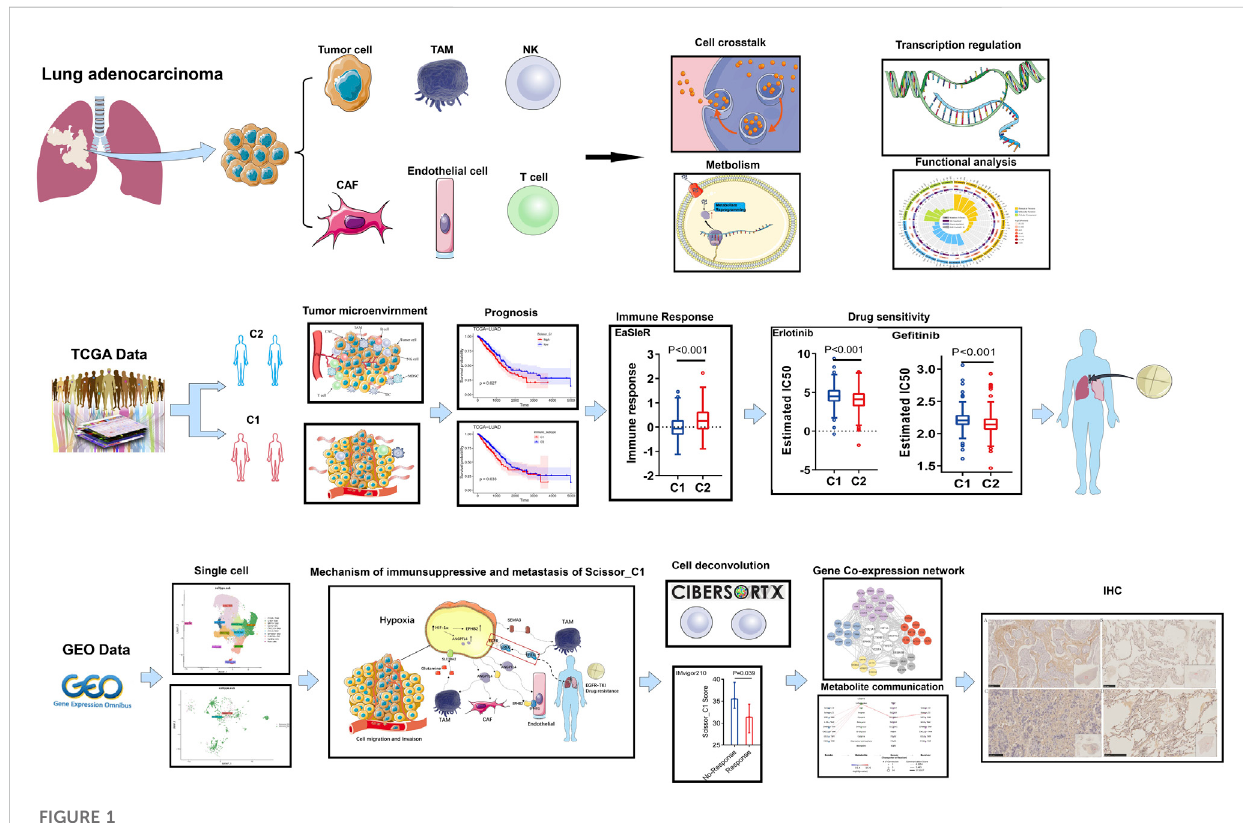
FIGURE 1 Overview of the work in this study.